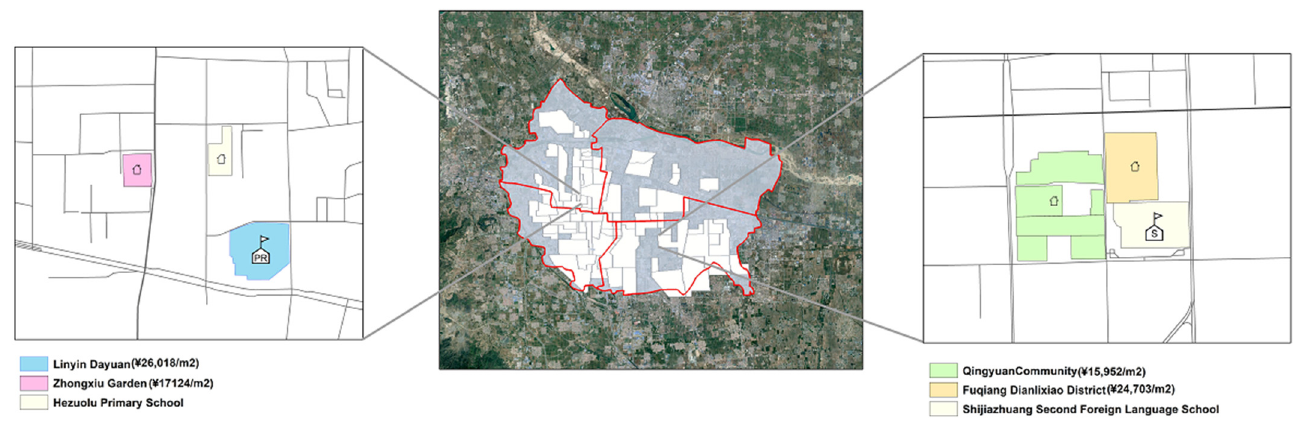
Figure 5. Special samples illustrating the residential land prices of school districts.